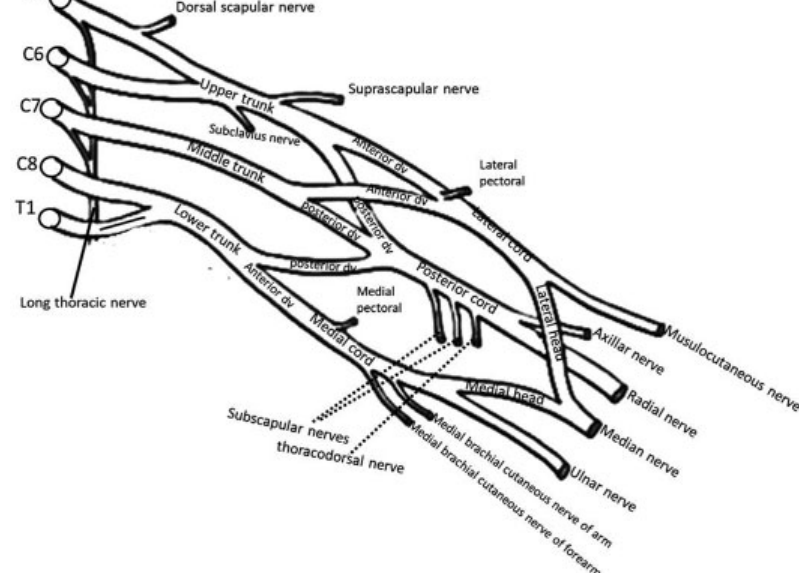
( ► Fig. 1 ). 3,4 Trunks are divided into three parts: the superior, middle, and inferior. Each trunk divides into two branches: anterior and posterior. The suprascapular nerve and the subclavius nerve arise from the upper trunk. 3,4 The posterior cord is formed by the posterior branches of all trunks, whereas the lateral cord is formed by the anterior branches of superior and middle trunks; the anterior branch of the inferior trunk alone makes the medial cord ( ► Fig. 2 ). 1 – 3 The posterior cord of BP is formed by the union of the posterior divisions of the upper, middle, and lower trunks. The upper subscapular, thoracodorsal, lower sub-